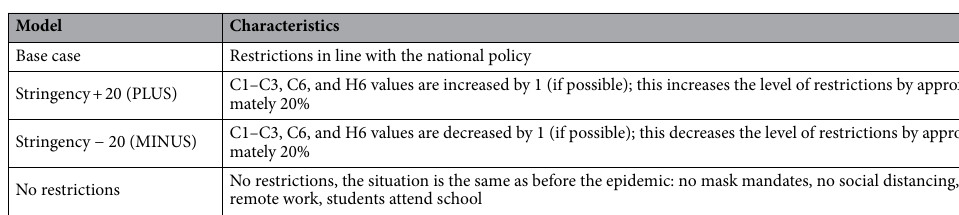
Figure 4. Stringency Index for Poland.